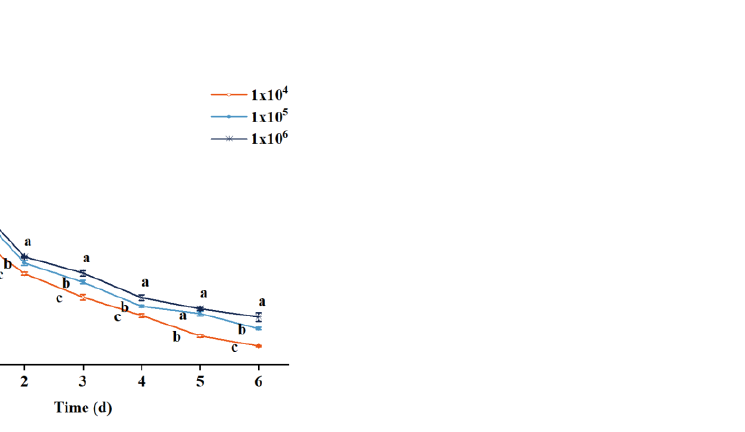
Figure 1. Initial pathogen load of the female adults of S. guani under different concentrations of B. bassiana spore suspensions. Different letters above the bars indicate significant differences (mean ± SE, n = 3 in each treatment).